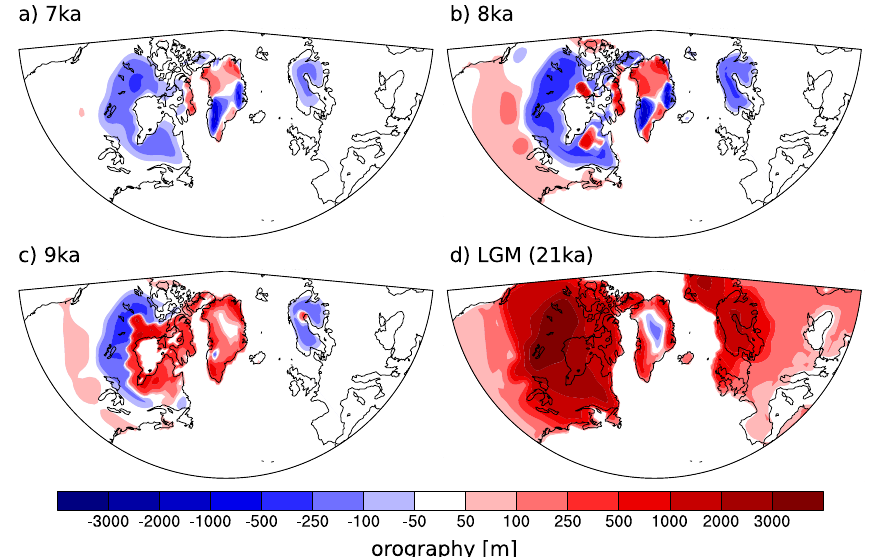
Fig. 1. Paleotopographies implemented in the model simulations: deviation from present-day mask [m] for (a) 7ka, (b) 8ka, (c) 9ka, and (d) LGM (21ka). All topographies are based on output from the ICE-5G model by Peltier